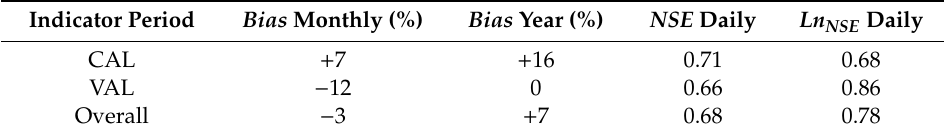
Table 5. Model e ffi ciency in calibration and validation periods. Indicators explained in Section 5.1.